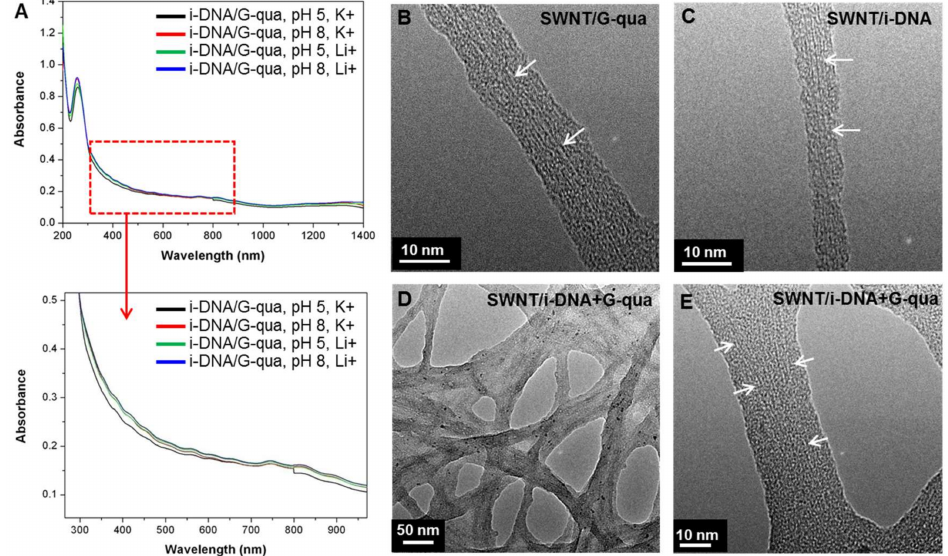
Figure 2. ( A ) UV-Vis absorbance spectra of mixture of i-DNA/f-SWNT and G-quadruplex/f-SWNT at pH 5 and 8 with 100 mM K + and Li + . TEM images of ( B ) G-quadruplex/f-SWNT; ( C ) i-DNA/f-SWNT; and ( D , E ) mixture of i-DNA/f-SWNT and G-quadruplex/f-SWNT. White arrows indicate the f-SWNT in the